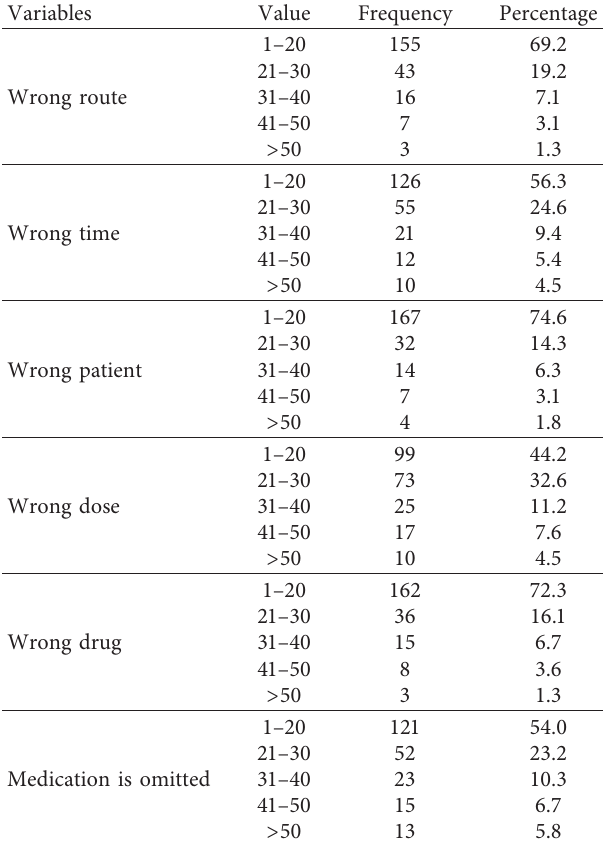
Table 4: Types of medication administration errors reported among nurses working in public hospitals of North Shoa Zone, Amhara, Ethiopia, 2019 ( n �